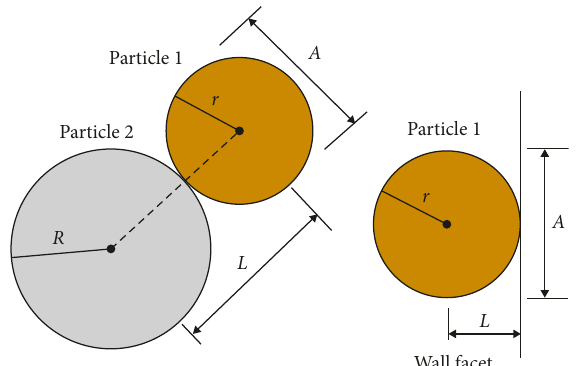
Figure 1: Relation between linear stiffness and effective modulus associated with contact.